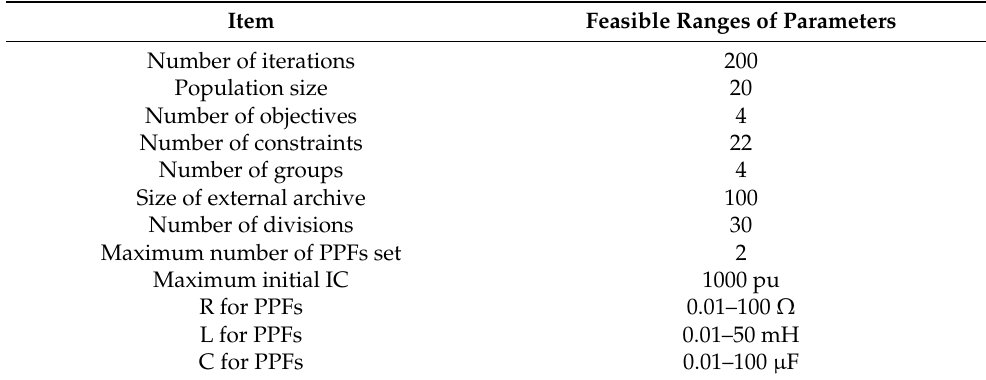
Table 5. Parameters of the proposed TLBO algorithm.